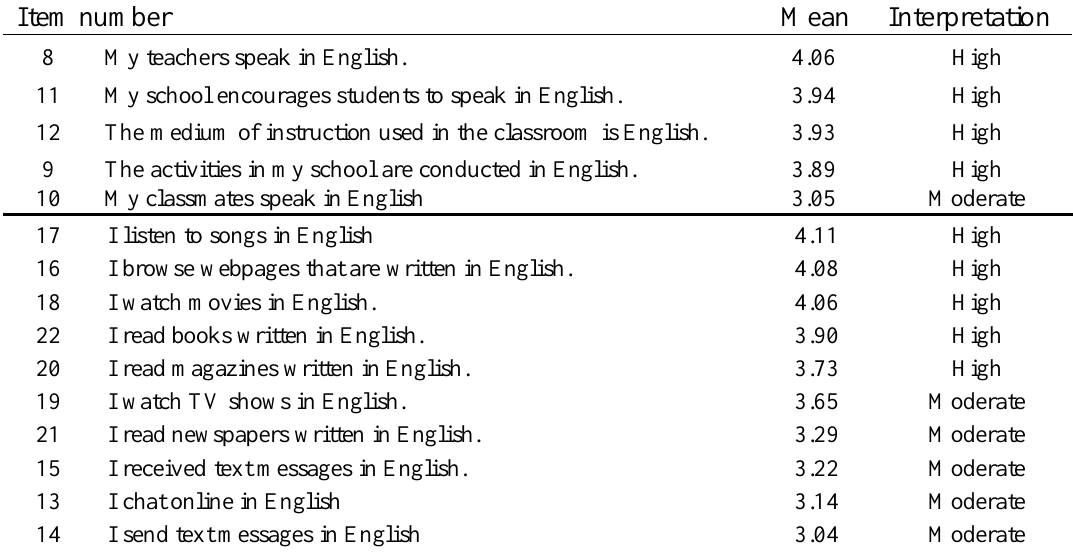
Table 4. Activities that Exposed Students to the English Language Item number